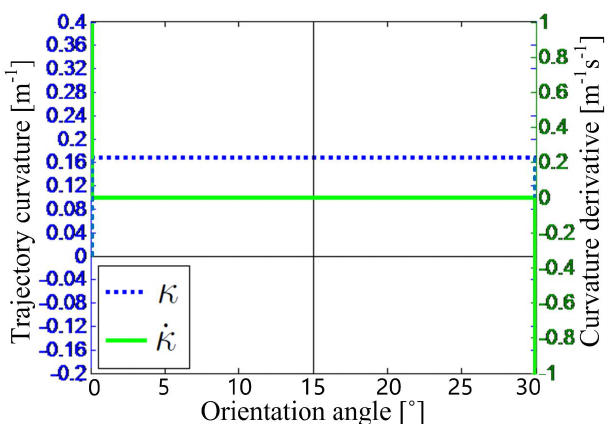
Figure 9. The curvature of the circular arc and its time-derivative.